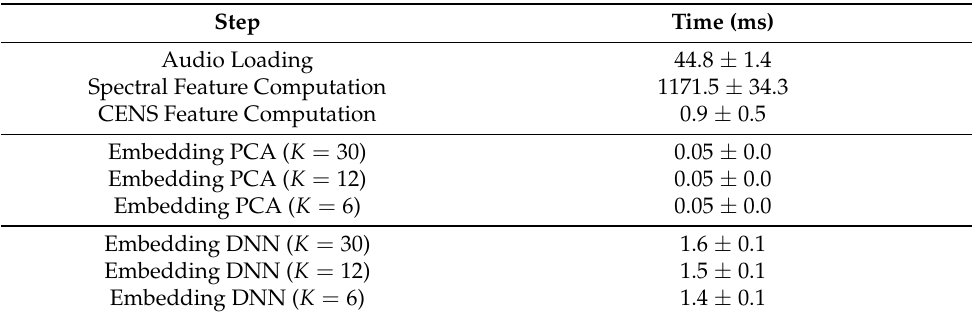
Table 4. Time measurements (in ms) for various steps involved in the feature computation of 20 s of